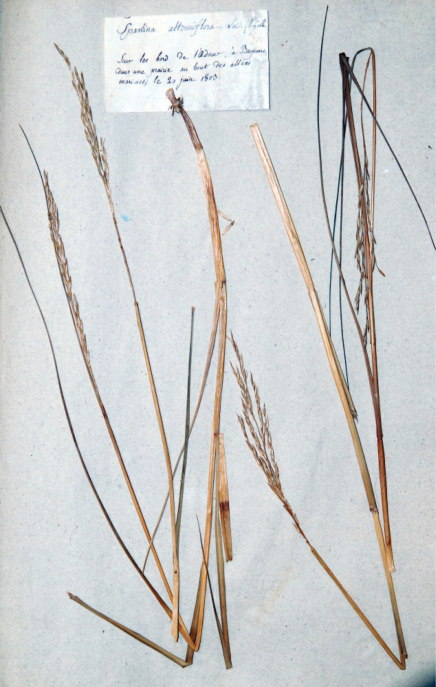
Holotype specimen of Spartina alterniflora (without collector, AV). Photo: Museum Requien. Specimen image reproduced with the permission of Museum Requien.